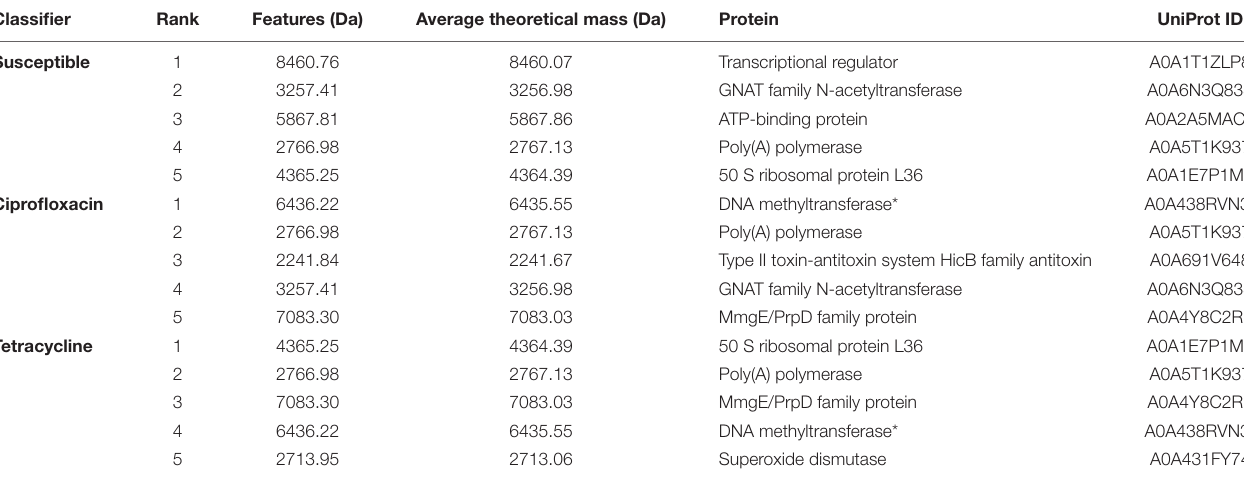
TABLE 4 | Top five ranking of Random Forest features of